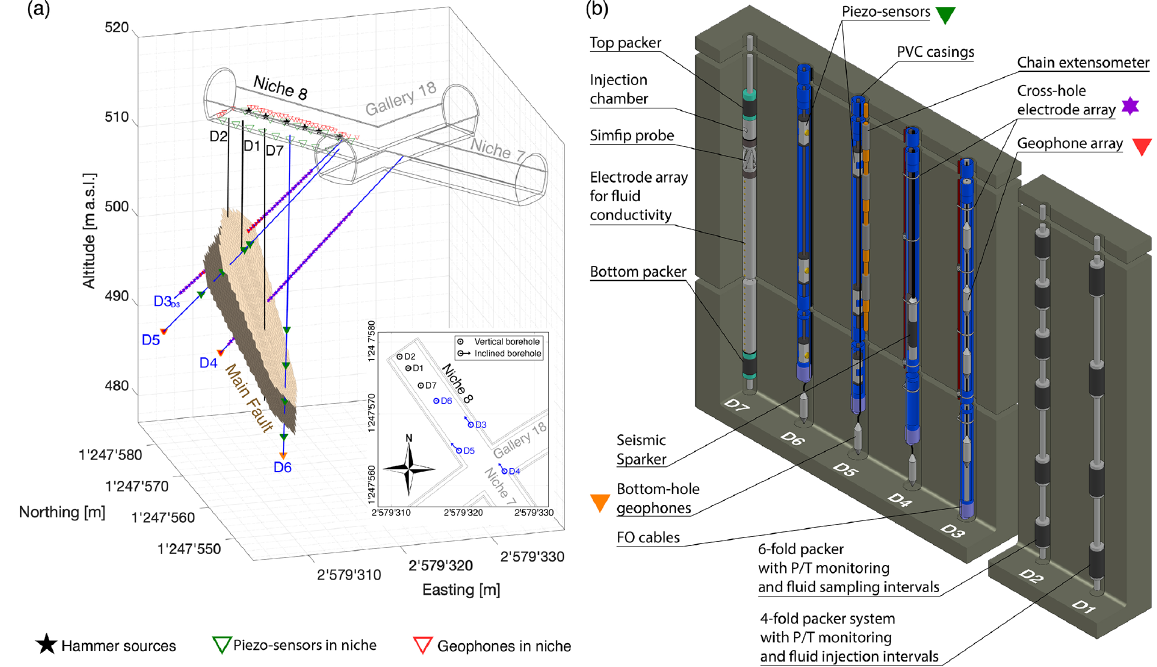
Figure 5. (a) Geometry of boreholes and of the main fault below niche 8; (b) planar view of the borehole location in niche 8.